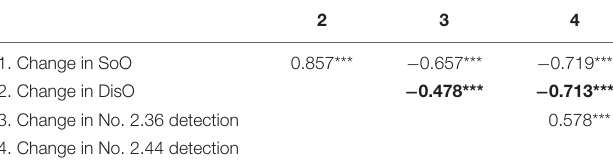
TABLE 1 | Correlation coefficients between all the amount of changes.